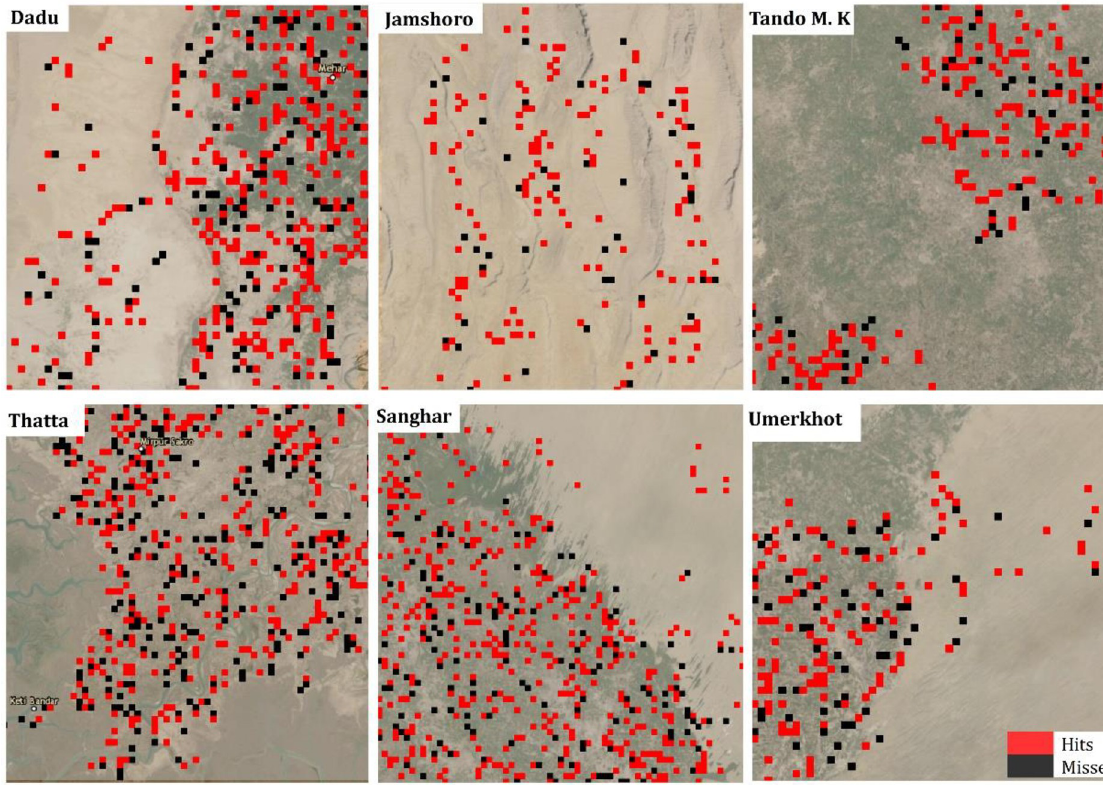
Fig 3. Cross-validation performance of ensemble CNN model in selected districts. Hits: observed poor and predicted poor. Misses: observed poor and predicted not poor.